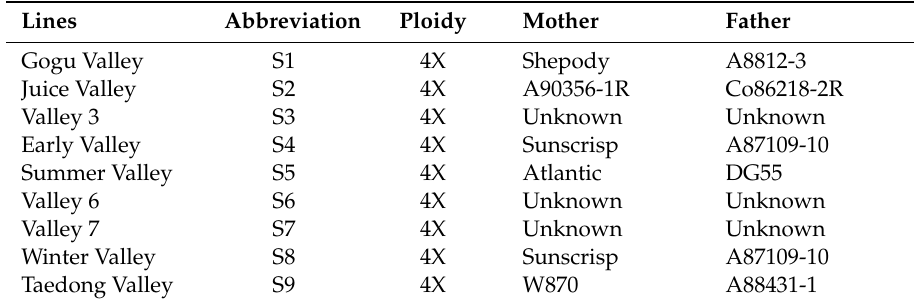
Table 1. List of 35 newly developed valley potato lines used in this study and their parental background.